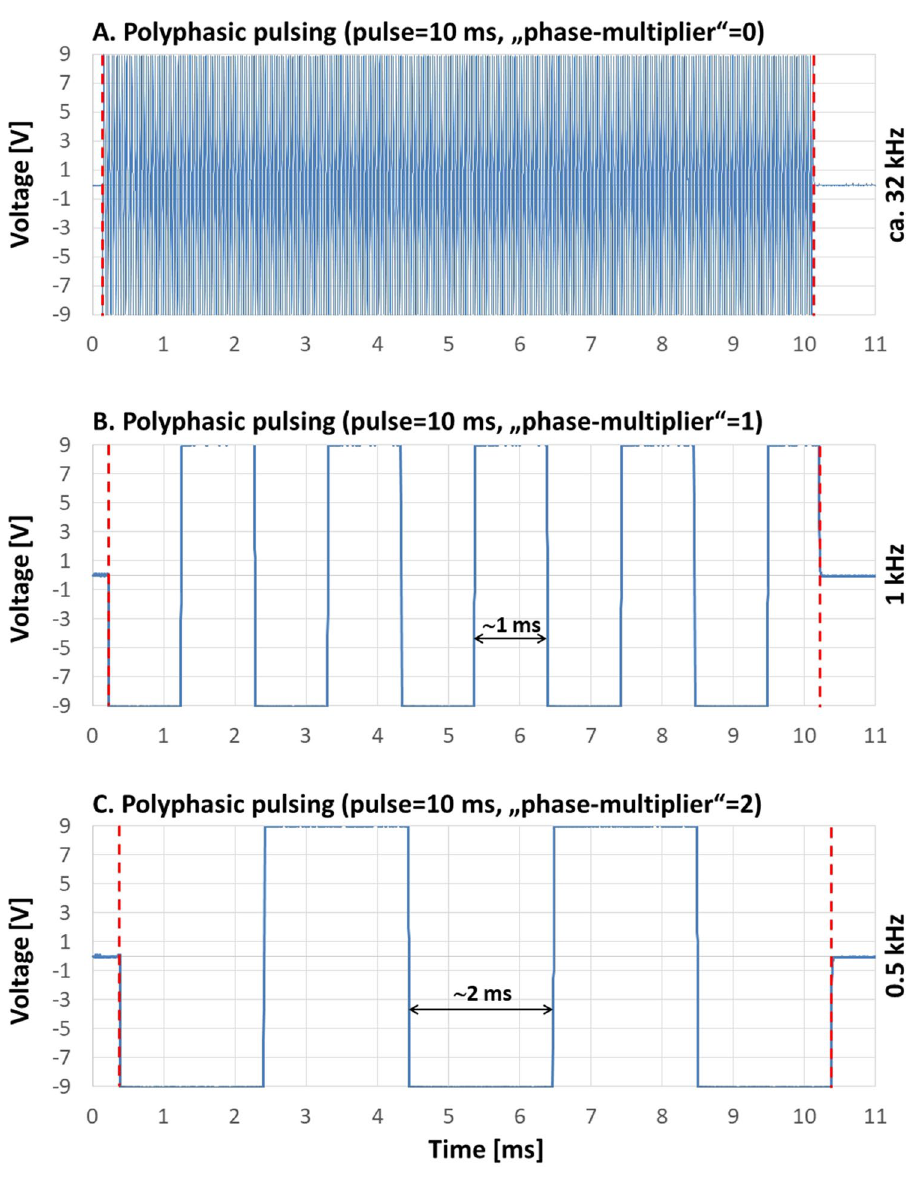
Figure 4. Multiphasic pulsing and effect of the “phase-multiplier”, measured with an oscilloscope. ( A ) Shows the measured output of the MyoPulser, with “polyphasic”-pulsing, a pulse time of 10 ms and a “phase- multiplier” of P = 0 applied. The AC-frequency of the according pulse was about 32 kHz, the maximum frequency the device can deliver. Increase of the phase-multiplier to P = 1 resulted in polarity inversion every single millisecond (1 kHz), shown at ( B ). Further increase of the multiplier to P = 2 results in polarity inversion every 2 ms (0.5 kHz), displayed in ( C ). The vertical dashed lines include the adjusted pulse time of 10